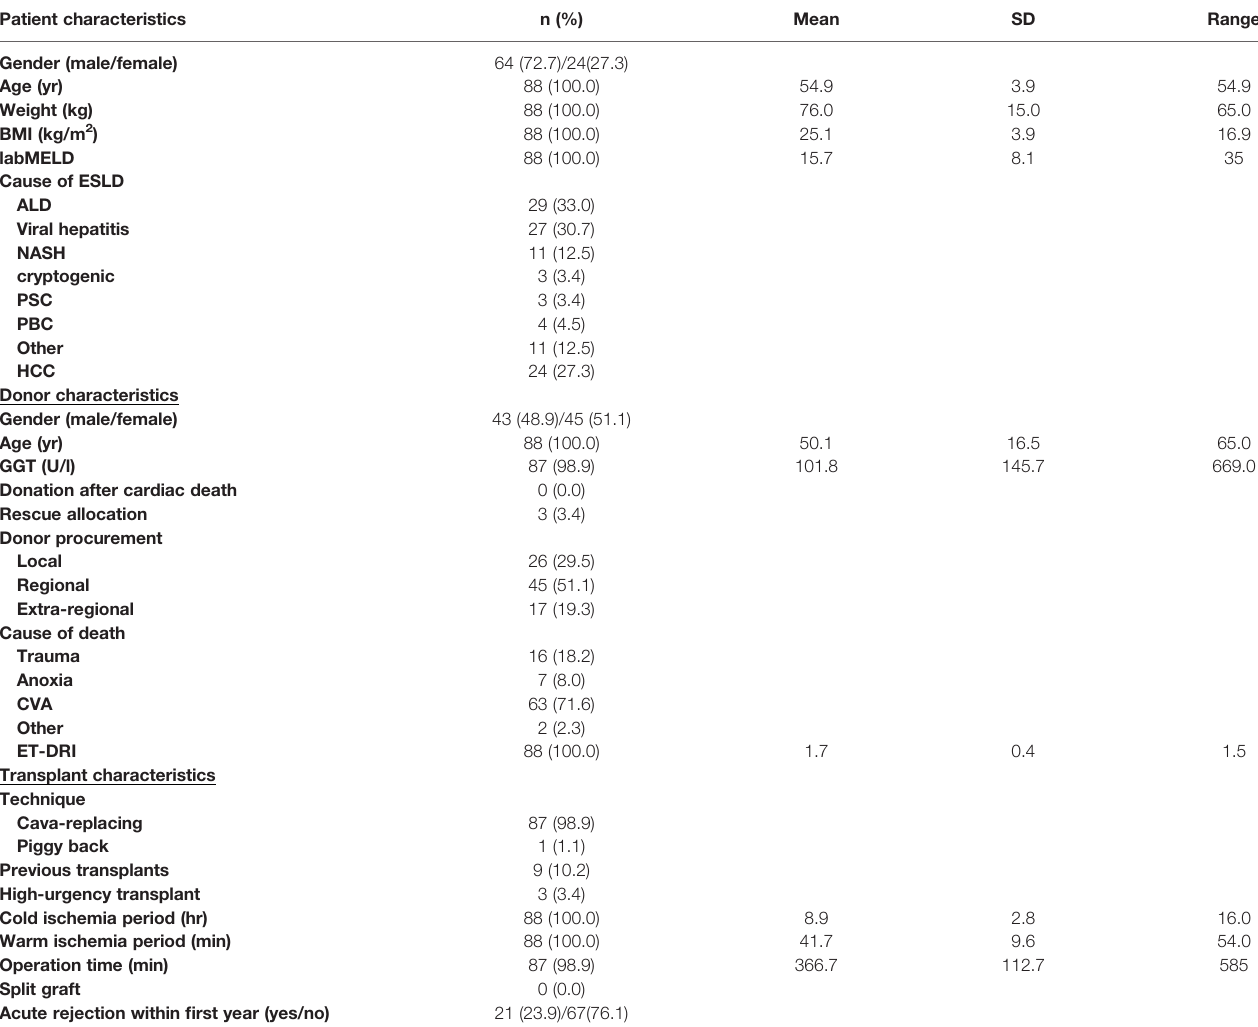
TABLE 1 | Demographic data of liver donors and